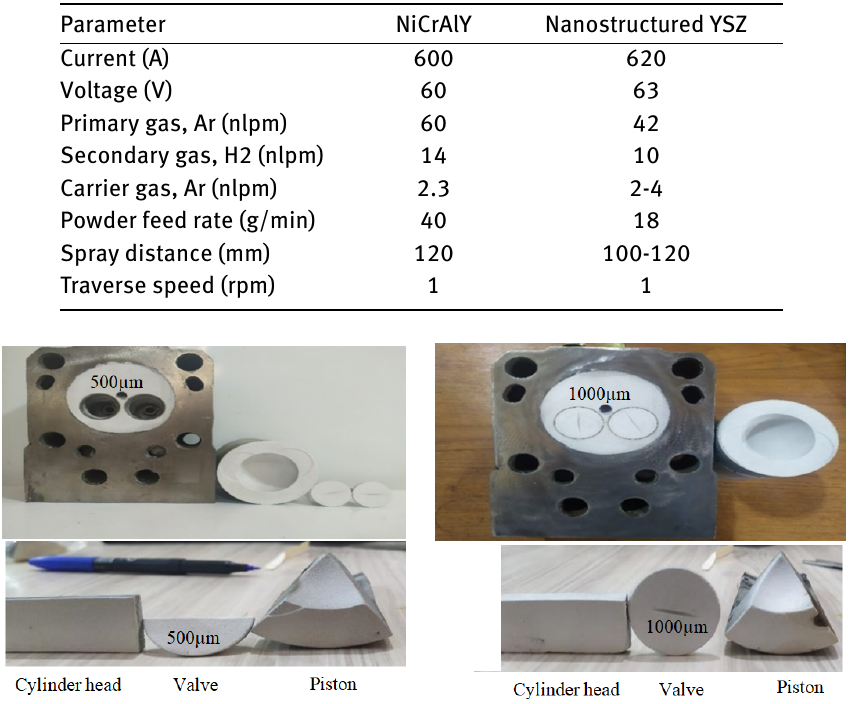
Table 1: Parameters of Plasma Spraying